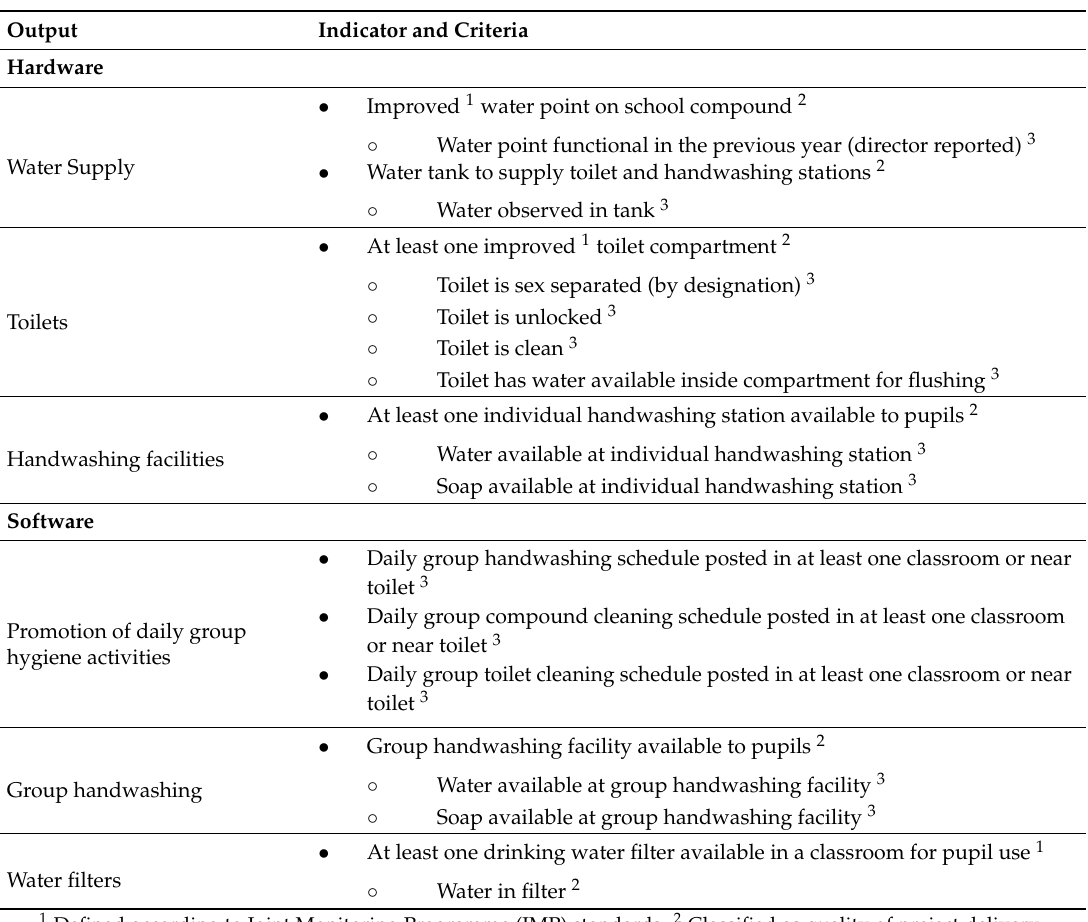
Table 1. Water, sanitation, and hygiene (WASH) in schools (WinS) project outputs and